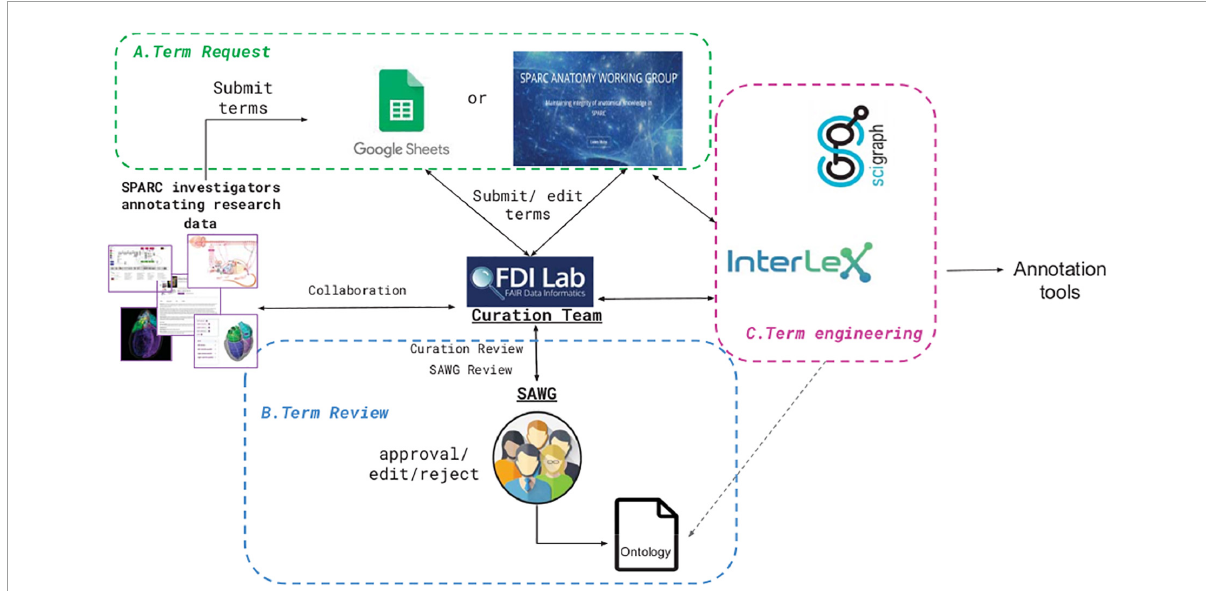
FIGURE6 SPARC term request and review pipeline. The process comprises three iterative steps: (A) submission (Term request), (B) Term review, and (C) Term engineering, shown in the three colored boxes. Details are provided in the text.